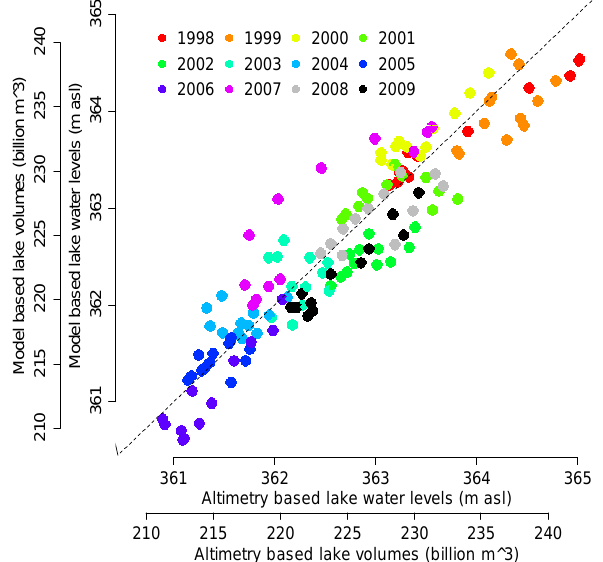
Fig. 8. Scatterplot of modelled water levels vs. satellite altimetry- based lake level data. Also shown is the scatterplot of modelled lake volumes vs. altimetry-based lake volumes. Each point repre- sents mean monthly modelled (calibrated) lake water levels or cor- responding lake volume over the combined period (January 1998 through December 2009). 1:1 line is shown as dotted